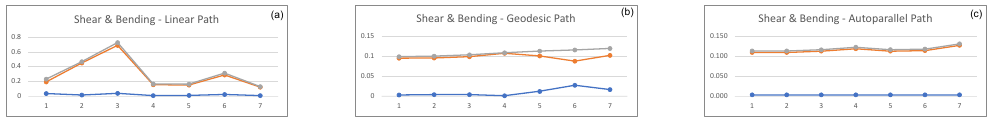
Figure 14. Trend of the energies for different interpolations: ( a ) Left: linear interpolation ( b ) Center: geodesics interpolation. ( c ) Right: autoparallel interpolation. Blue refers to d u , red to d b , grey to d tot